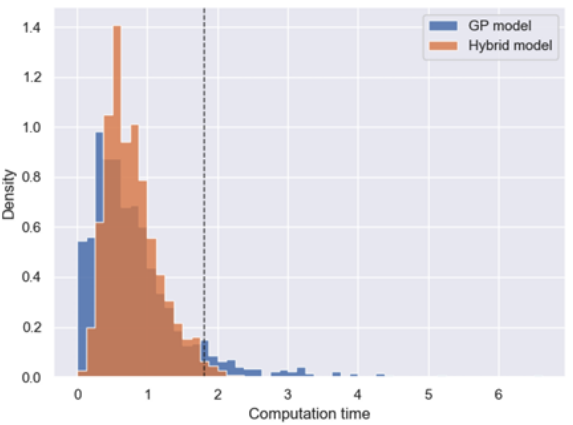
Figure 8. Computation time